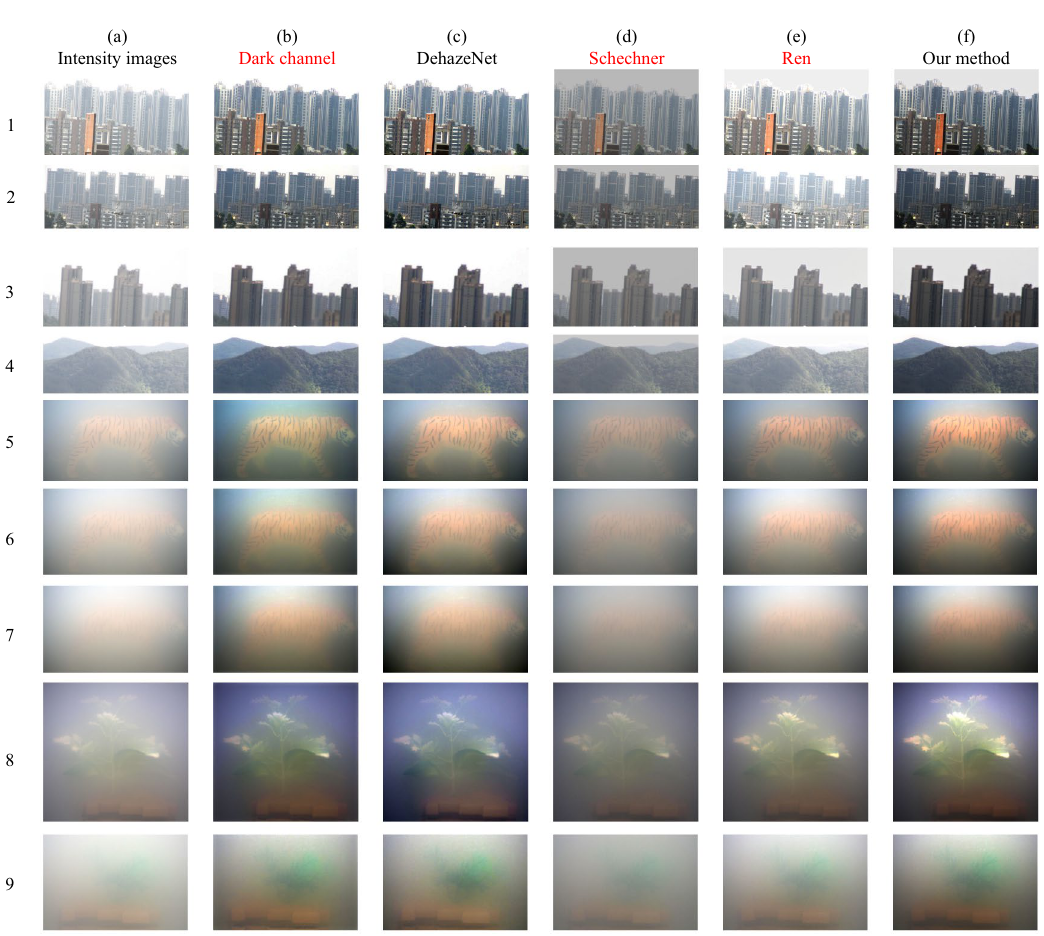
Figure 4. The groups of 1–4 are the buildings and hills in the foggy weather. The groups of 5–9 are the underwater experiments in the milk solution with different concentrations. ( a ) is intensity image ( S 0 ), ( b ) is the restored image with dark channel prior, ( c ) is the restored image with DehazeNet, ( d ) is the restored image with Schechner’s method, ( e ) is the restored image with Ren’s method, ( f ) is the restored image with proposed